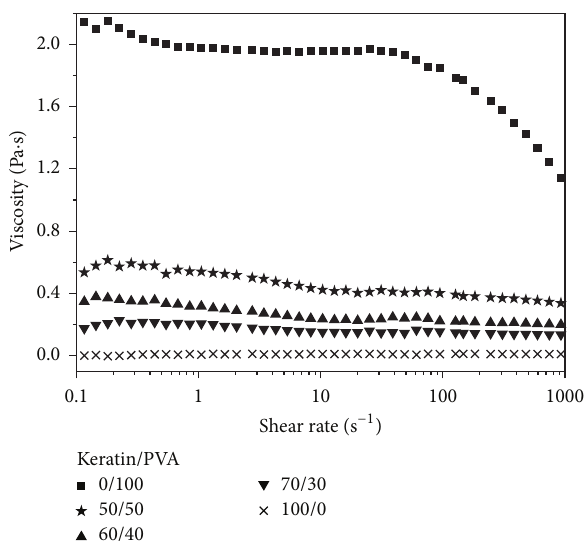
Figure 1: Rheological behaviors of the keratin/PVA blend solutions.